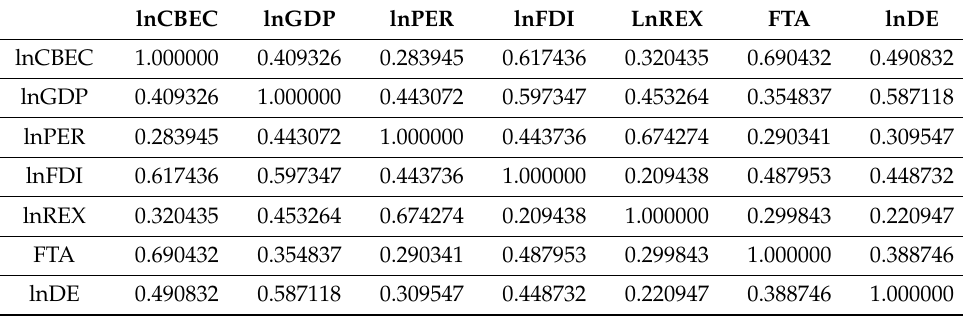
Table 2. Correlation coefficients among independent